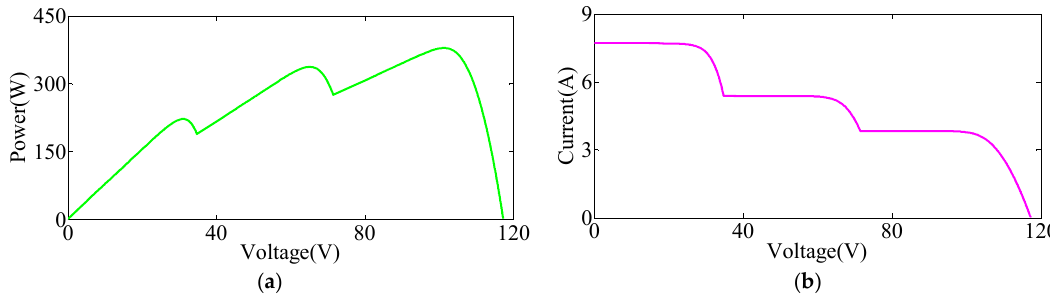
Figure 15. The output characteristics of the PV array for partial shading conditions ( a ) P-V curve; ( b ) I-V curve.